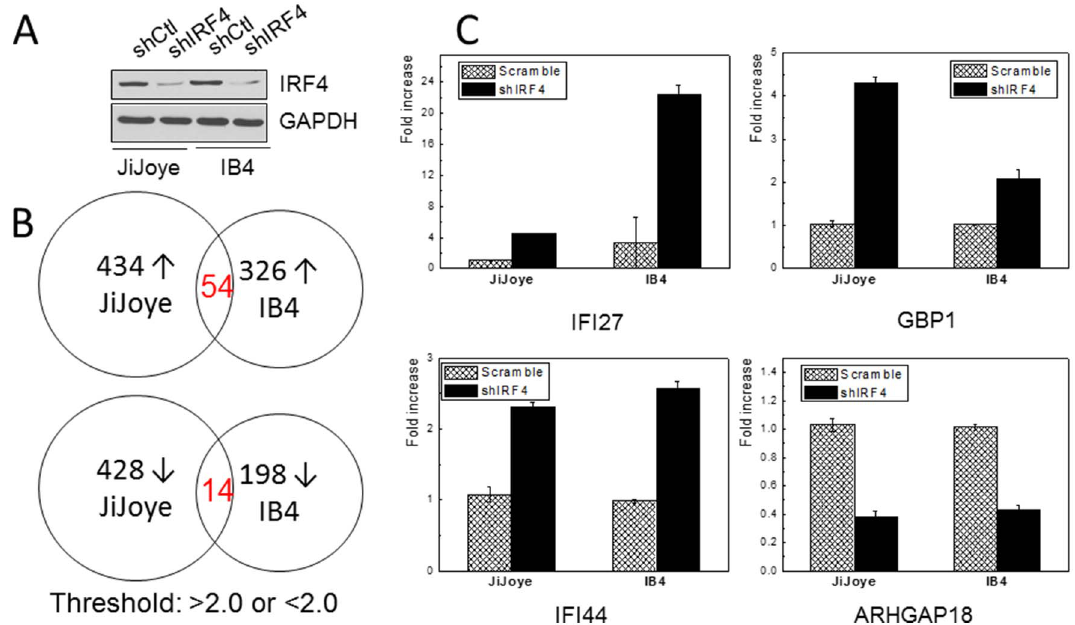
Figure 5. IRF4 transcriptome in EBV latency. A . Expression of endogenous IRF4 in JiJoye (EBV + Burkitt’s lymphoma cell line) and IB4 (EBV + LCL) cell lines were depleted by retrovirus-mediated transfection of shIRF4 (or control)-expressing retrovirus. Stable transfectants were selected with hygromycin and shIRF4 (or control) was induced by 1 m g/ml doxycycline. B . Total RNAs were extracted and subjected for Microarray analysis. Genes with . 2.0 and , 2.0 fold changes were selected. C . Real-time PCR confirmation of IRF4 transcriptional targets IFI27, GBP1, IFI44, and ARHGAP18.